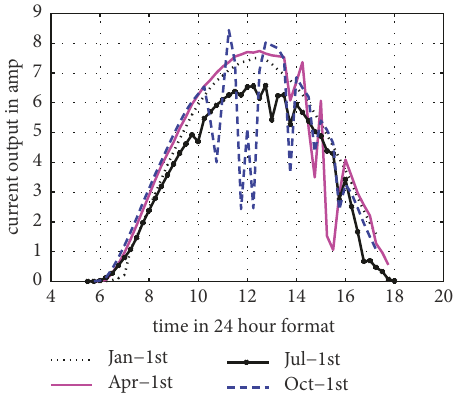
Figure 13: Hourly variation of currentoutput of Kyocera 200GT PV module for 2 Ω resistance.